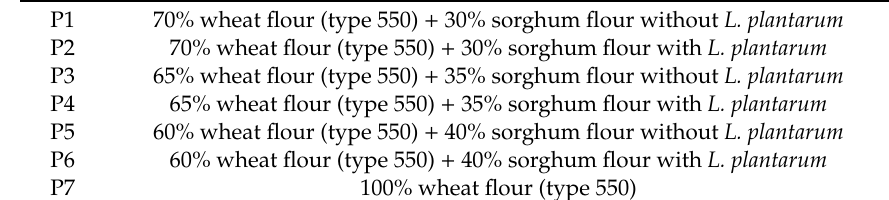
Table 1. Types of flours used in the